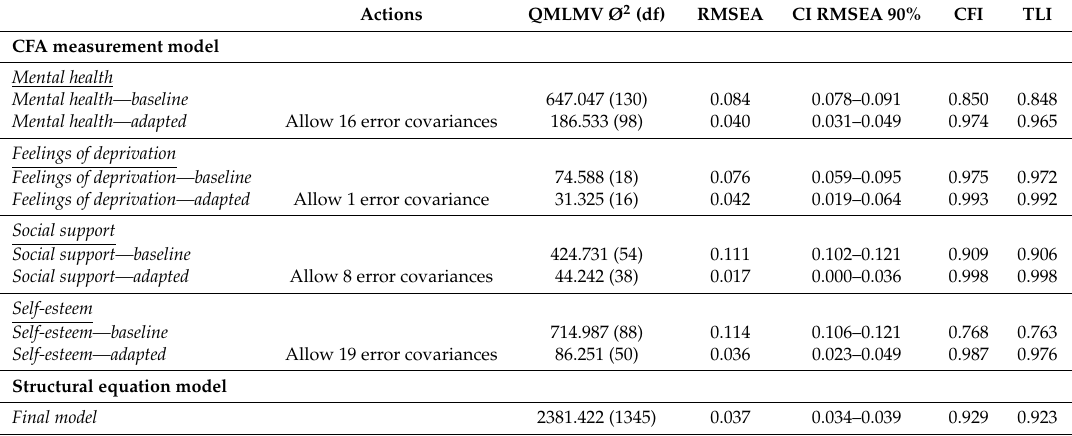
Table 3. Summary of the goodness-of-fit statistics for the CFA measurement models and structural equation